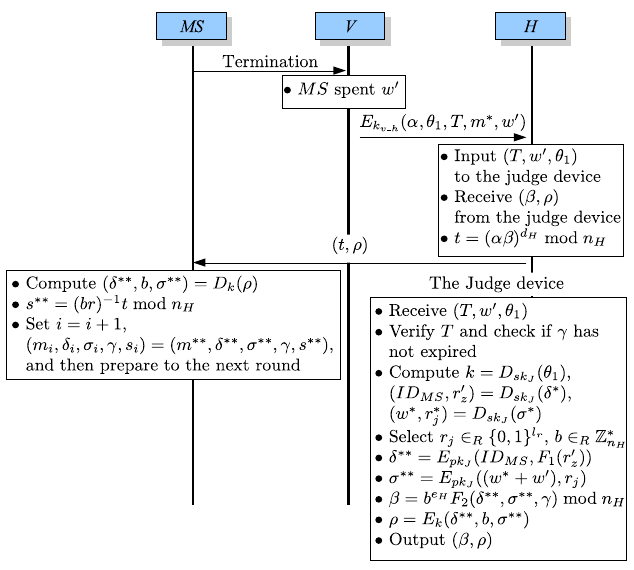
Figure 5. The protocol for terminating the communication and getting a returned ticket for the next round of